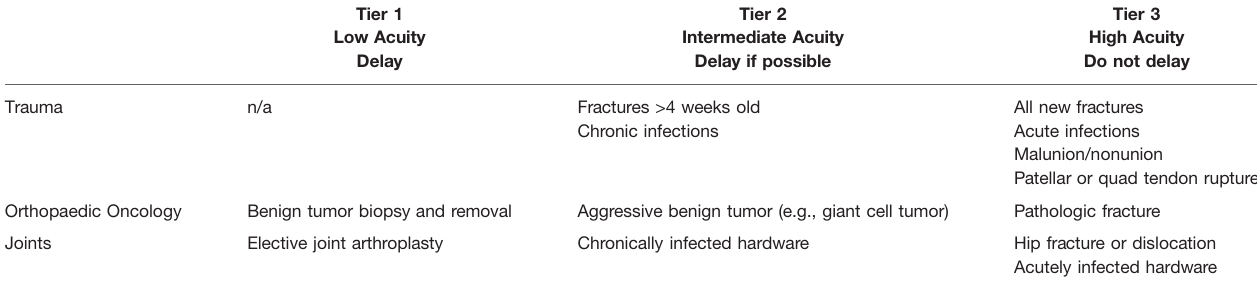
TABLE 3 | Orthopaedics Elective Surgery Acuity Scale (ESAS). All candidates for surgery should be assessed for surgical fi tness on an individual basis. This is an example ESAS and not comprehensive. Procedure acuity for the individual patient may shift among tiers based upon acuity of illness, severity of COVID-19 infection and coagulopathy, and hospital surgical capacity (135). For speci fi c length of operative delay, please see the text and Association of Anesthesiologists guidelines